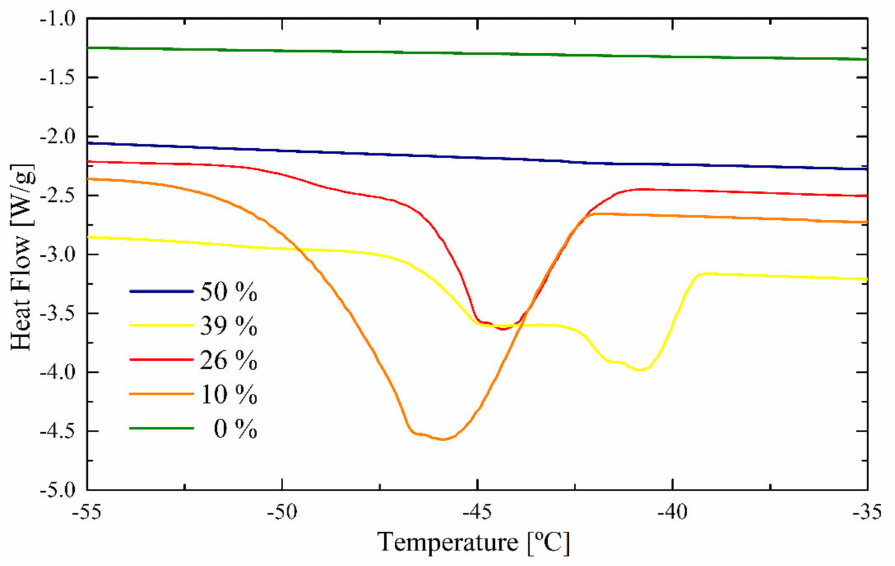
Figure 11. DSC peaks for bound freezing of the PEGMA latex.